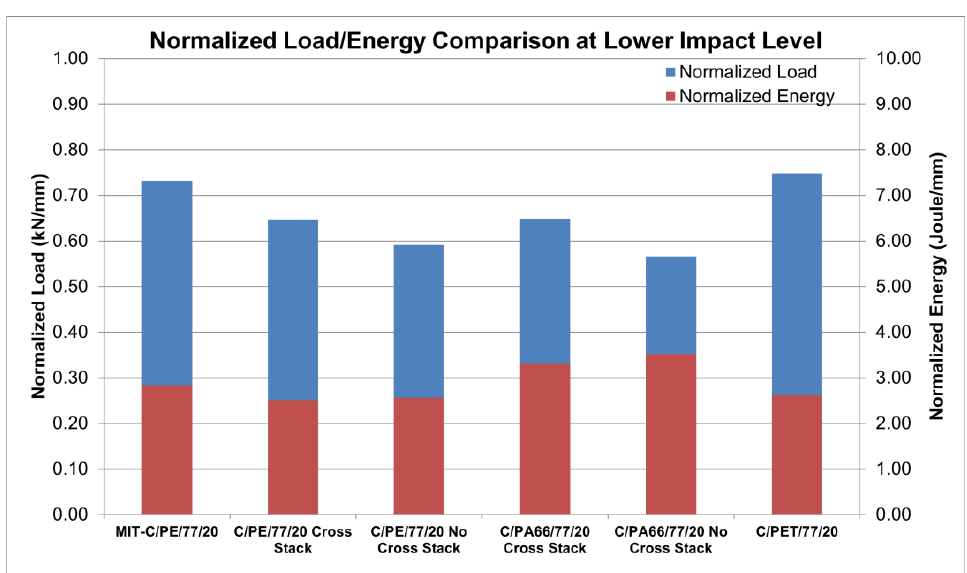
Figure 3. Comparison at normalized load and normalized energy for rCF variants at 5 J impact en- ergy.